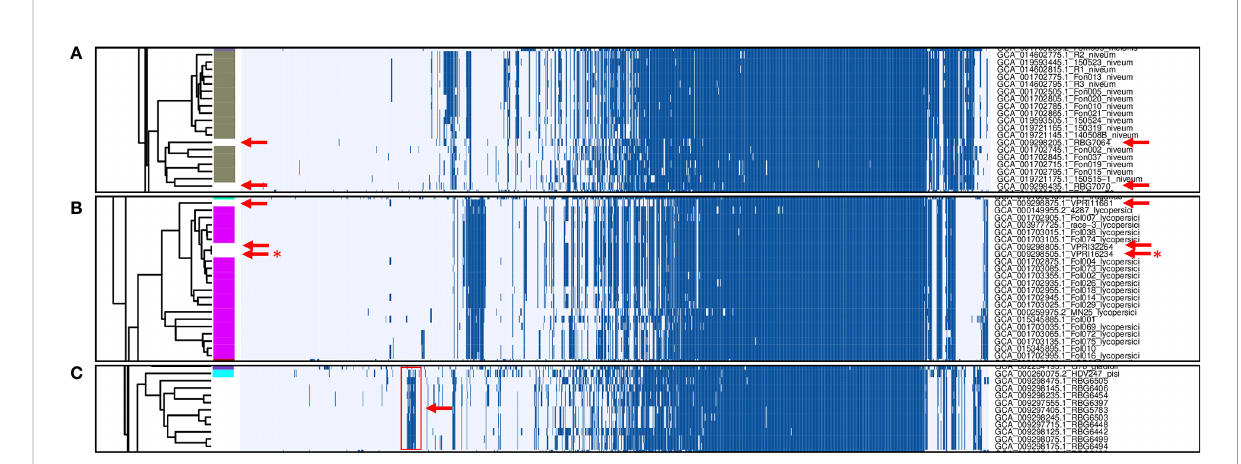
FIGURE 3 Zoomed-in examples of presence/absence variation in F. oxysporum genomes without a forma specialis (f. sp.) annotation. (A) Gaps in annotated f. sp. niveum strains (gray) correspond to genomes originating from Citrullus lanatus samples (red arrows). (B) Gaps in annotated f. sp. lycopersici strains (magenta) are fi lled by genomes resulting from Solanum lycopersicum samples (red arrows) and one genome associated with a Solanum tuberosum sample (red asterisk). (C) non-annotated samples clustering together with the f. sp. pisi HDV247